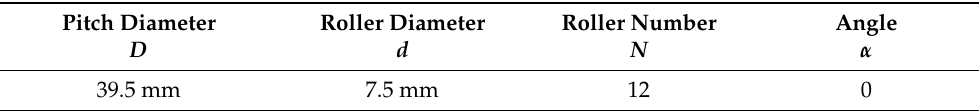
Figure 10. The outer ‐ ring fault bearing. Table 7. Bearing parameters. Pitch Diameter D